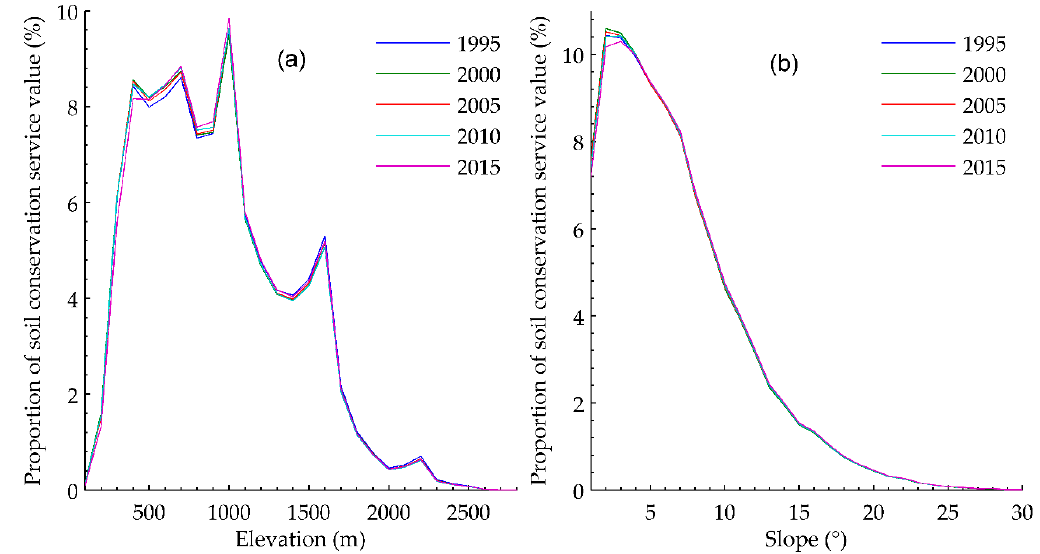
Figure 6. Vertical spatial heterogeneity of the soil conservation service value (SCSV). The SCSV percentage change along ( a ) elevation and ( b ) slope in the Three Gorges Reservoir Area.